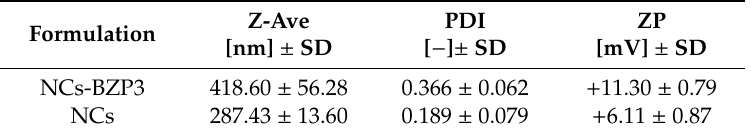
Table 2. The values of Z-Ave, PDI and ZP for polymeric